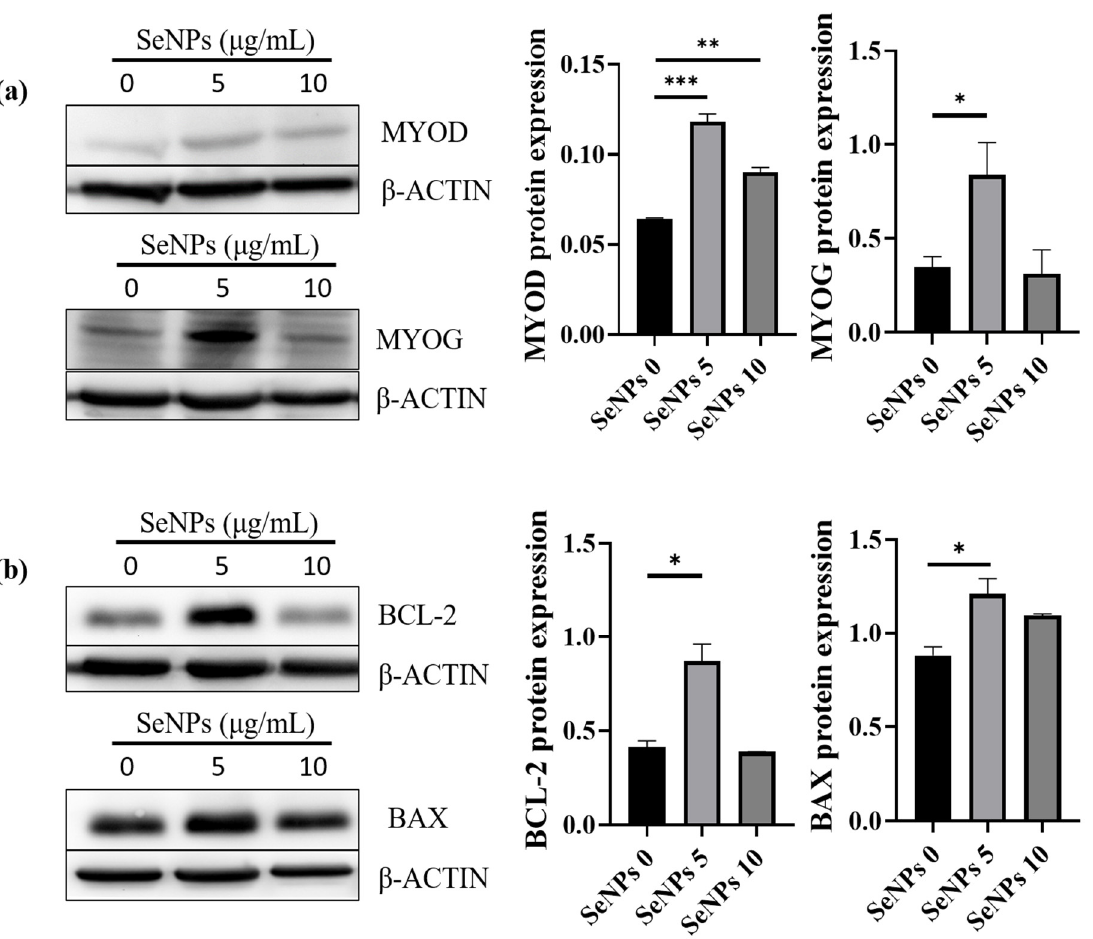
Figure 7. SeNPs upregulate myogenic markers during C2C12 cell differentiation and prevent apoptosis. ( a ) SeNPs promote myogenic differentiation and ( b ) increase cell viability by protecting C2C12 cells under 50 µ M of H 2 O 2 for 5 days. Statistical significance was calculated using one-way ANOVA, followed by a two-sided Dunnett post hoc test compared to the untreated SeNPs group. * Represents p < 0.05, ** p < 0.01, and *** p < 0.001; n = 3.